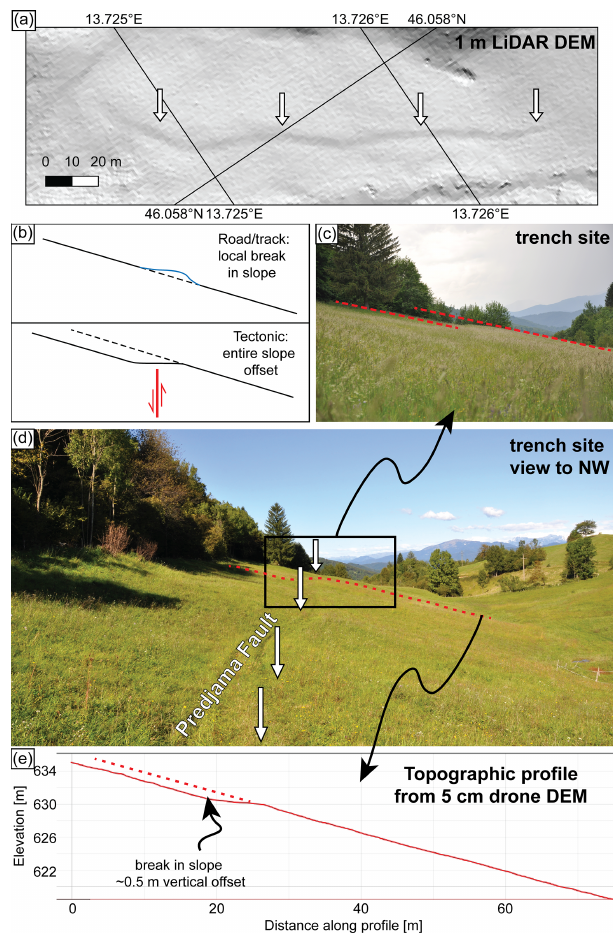
Figure 6. Morphology of the Predjama Fault at our trench site. (a) An uphill-facing break in slope can be traced for ∼ 200m (white arrows; 1m DEM lidar hillshade is illuminated from the northeast in this figure only). (b) Conceptual sketch illustrating the differ- ence between a tectonic scarp and a local break in slope due to road/track construction (Copley et al., 2018). (c) A break in slope offsets the trench site. The red dashed lines show ∼ 0.5m vertical offset. (d) NW view of the trench site (also see Fig. 6 for loca- tion). The red dashed line marks the location of the topographic profile in (e) . Trench 1 was opened across this profile. (e) Topo- graphic profile from a drone DEM with 5cm resolution, illustrat- ing the systematic offset of the slope and the uphill-facing scarp. This DEM is available at http://www.opentopography.org (last ac- cess: 26 March